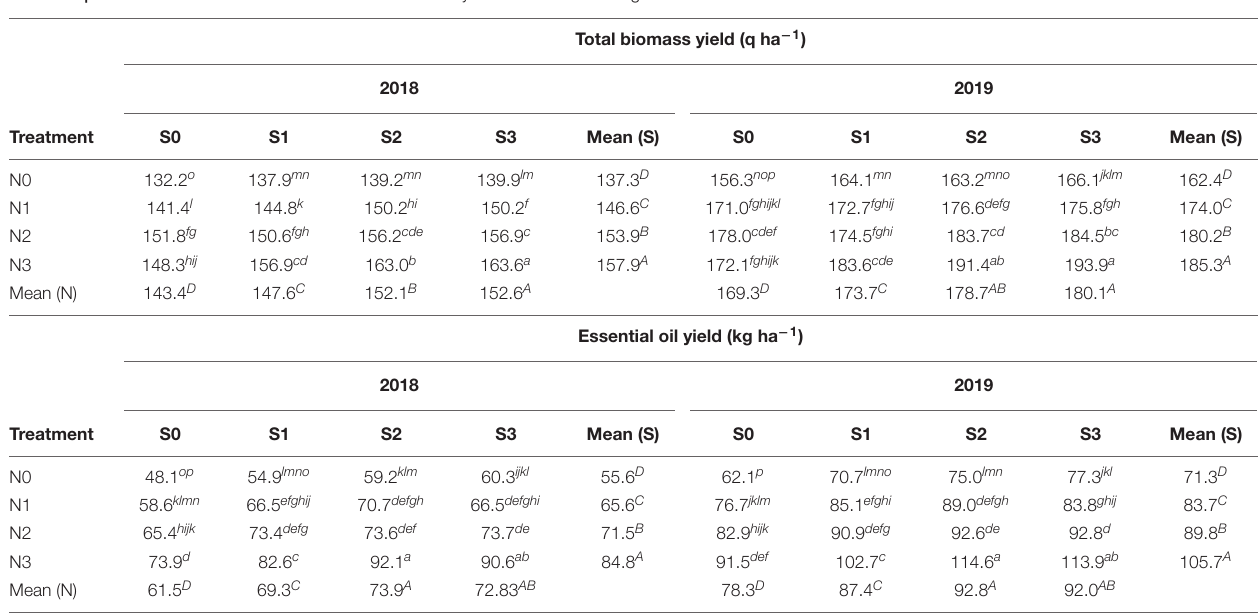
TABLE 5 | Interaction effect of N and S fertilization levels on yield of T. minuta during 2018 and